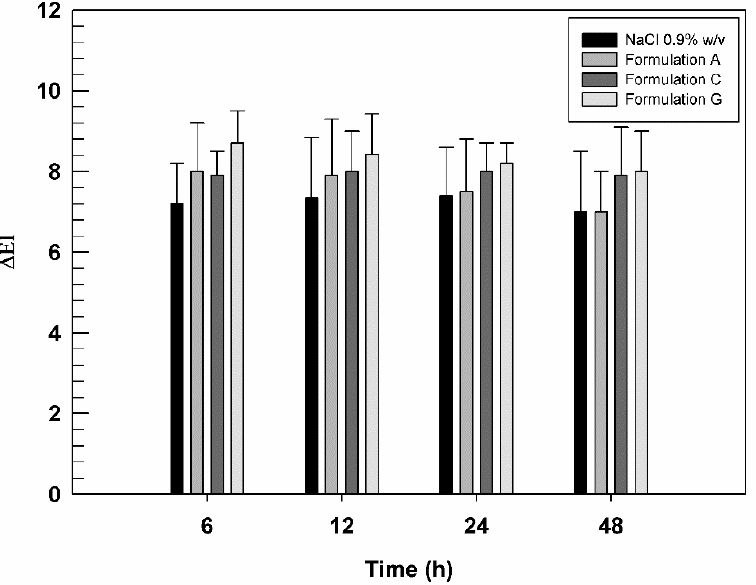
Figure 6. In vivo tolerability of saline solution (NaCl 0.9% w / v , used as negative control), Formulation A, Formulation C, and Formulation G, evaluated on human healthy volunteers and by using X-Rite apparatus. The results are expressed as mean values of erythematous index variation versus time. The results obtained for tested formulation are not statistically significant when compared with saline solution.